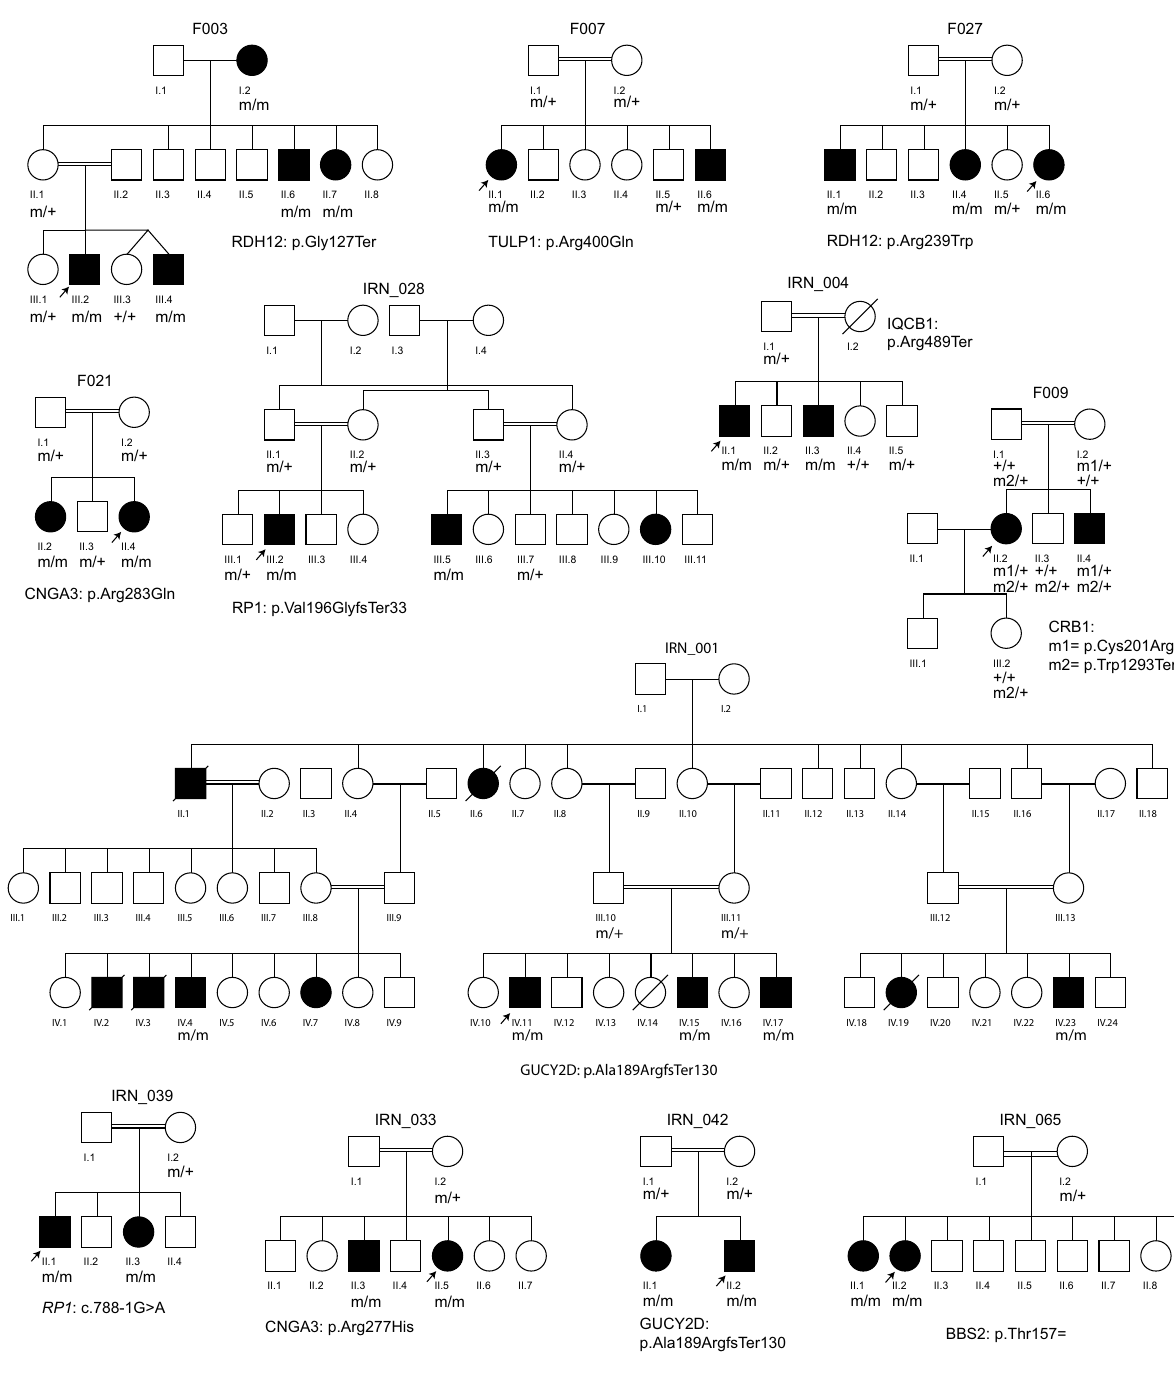
Figure 1. Pedigrees showing genotype–phenotype co-segregation for all detected variants. m, variant identified; + , wild-type